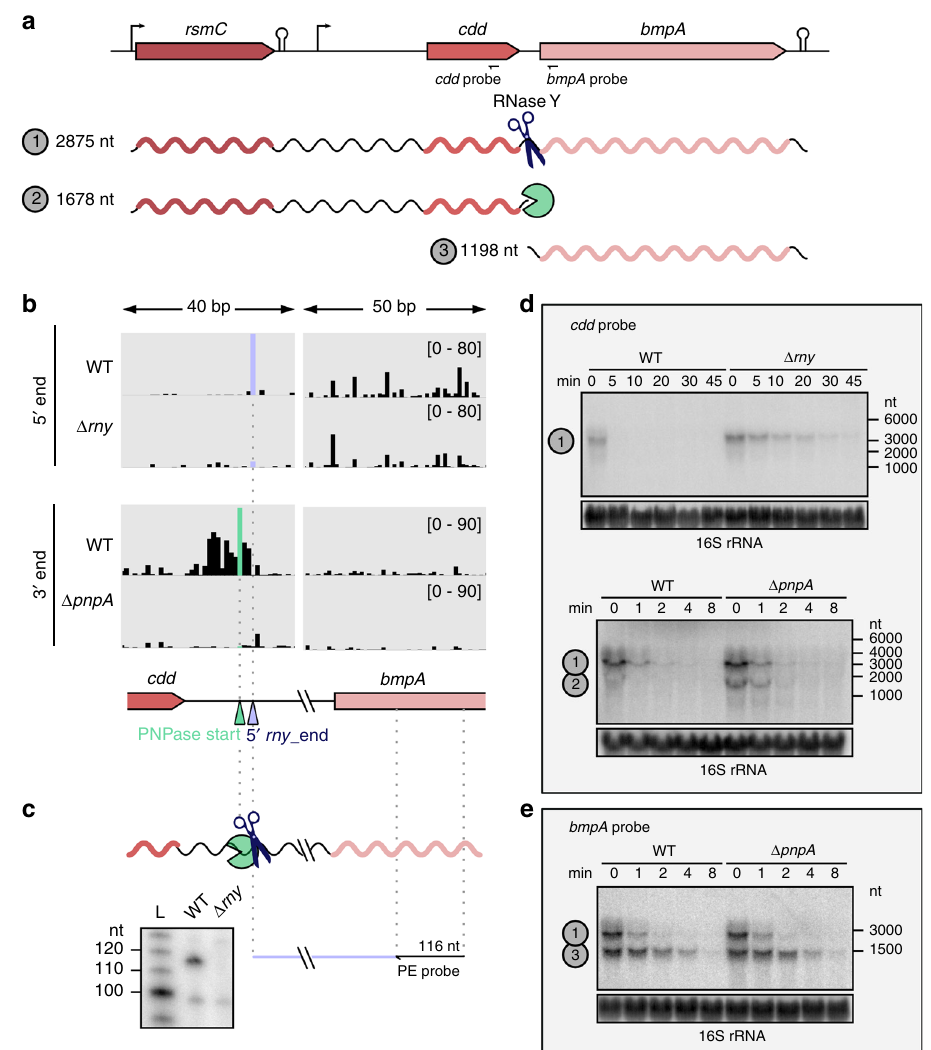
Fig. 9 The concerted action of RNase Y and PNPase is responsible for the differential RNA stability of the rsmC - cdd - bmpA operon. a Schematic representation of the rsmC - cdd - bmpA operon; the location of the promoter, terminator and probes used in the northern blot analyses and predicted RNA sizes are shown. b 5 ′ and 3 ′ end RNA sequencing coverages in the WT and Δ rny strains (for the 5 ′ end) and in the WT and Δ pnpA strains (for the 3 ′ end) of a region comprising portions of the cdd and bmpA ORFs and the intergenic region between the two genes. The coverage scale is indicated between brackets. The 5 ′ rny _end and the PNPase trimming start position identi fi ed in the cdd - bmpA intergenic region are depicted with purple and green arrowheads, respectively. c RNA 5 ′ end in the cdd - bmpA intergenic region in the WT and Δ rny strains, generated by RNase Y (scissors) and identi fi ed by primer extension analysis. The primer used is depicted with an arrow and binds upstream of the RNase Y processing and PNPase start positions ( ‘ pacman ’ symbol). The size of the expected cDNA product is indicated. Shown are the results of one representative primer extension experiment ( n = 3). d , e The stability of rsmC - bmpA _ cdd , cdd and bmpA RNAs was determined by northern blot analyses up to 45 or 8 min after the addition of rifampicin in the WT and Δ rny strains or in the WT and Δ pnpA strains. Shown are the results of one representative northern blot analysis ( n = 3). The 16 rRNA was used as a loading control. Source data are provided as a Source Data fi